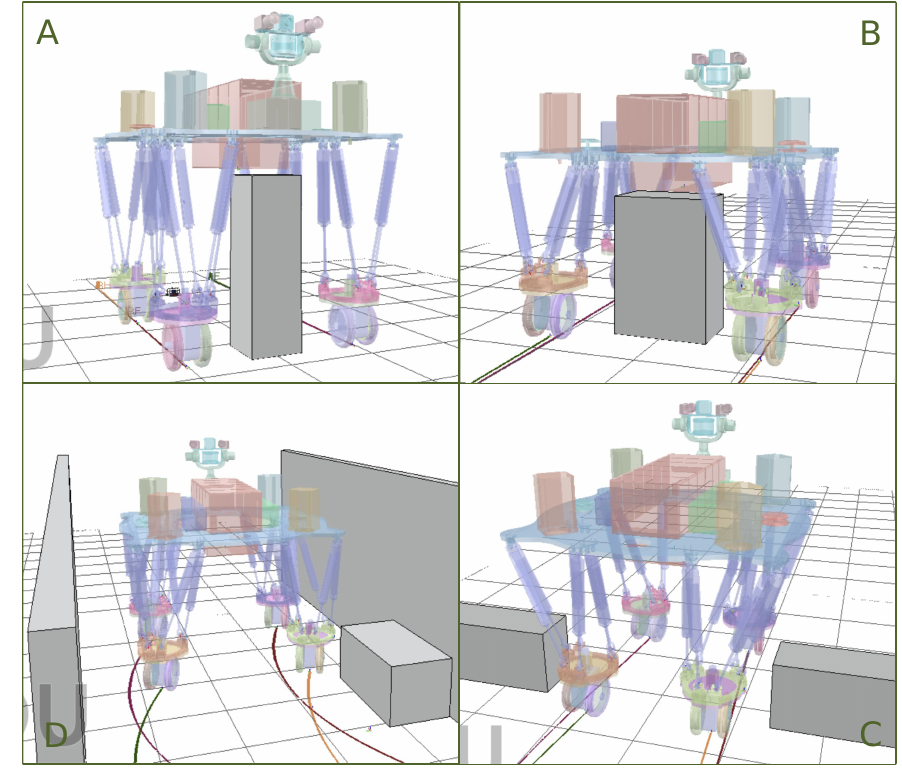
Figure 7. Four assignments to default destination in V-REP simulation: ( A ) Lift overhang routine ( B ) Broaden accommodation routine ( C ) Rotate clearance routine ( D ) Slim gap